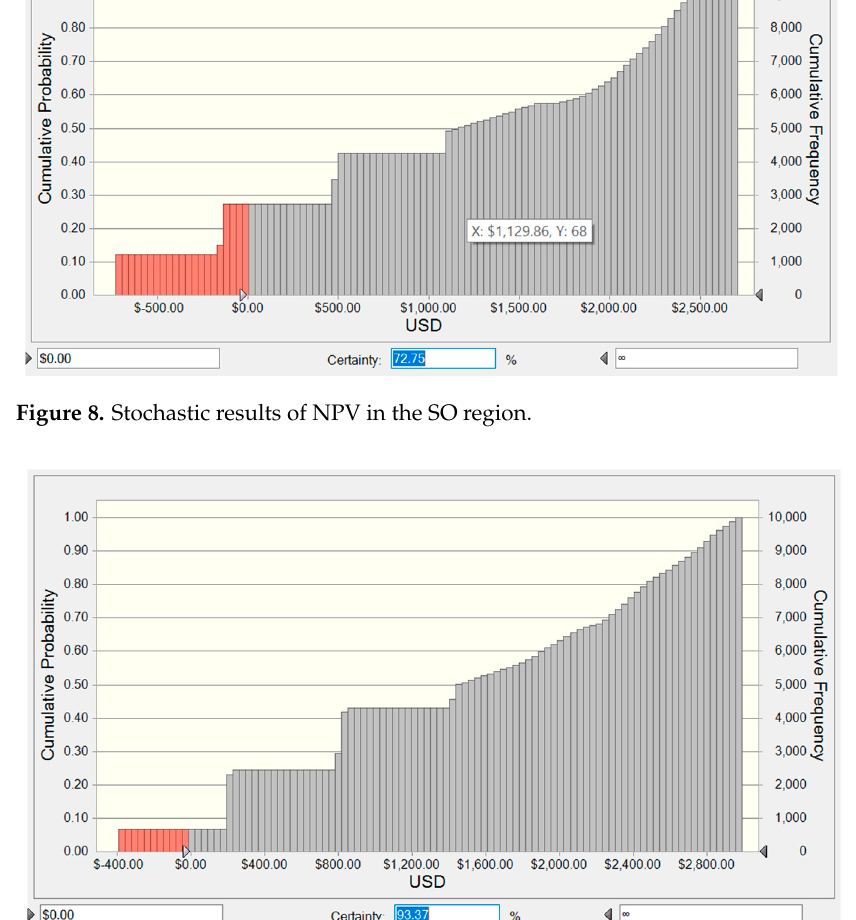
Figure 9. Stochastic results of NPV for the Brazilian scenario.